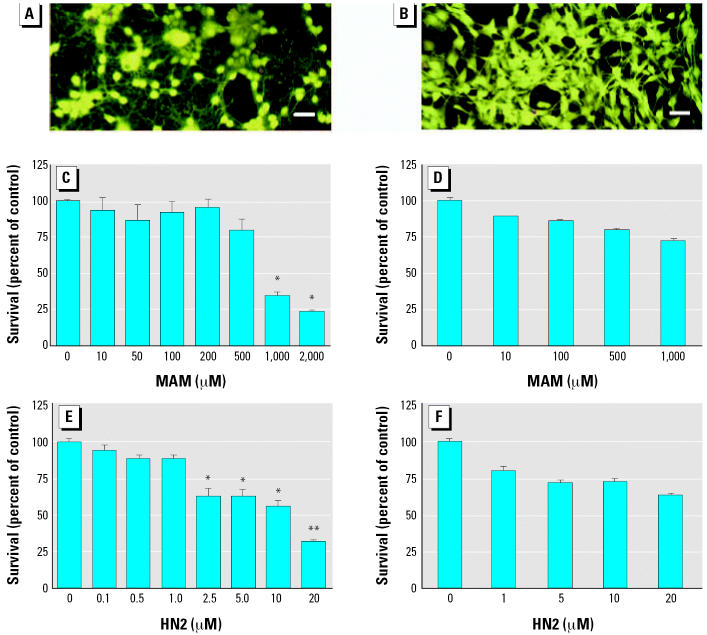
Comparative sensitivity of neurons and astrocytes to MAM or HN2. Representative epifluorescence micrographs of cultures of cerebellar neurons (A) and astrocytes (B). Bars = 50 μm (A) and 100 μm (B). Cultures of murine cerebellar granule cells (C,E) and astrocytes (D,F) were treated with various concentrations of MAM (10–1,000 μM) or HN2 (0.1–20 μM) for 24 hr, incubated with calcein acetoxymethyl ester and the cells examined for fluorescence. Values represent the mean percent survival of controls ± SE (n = 6/treatment, 2–3 experiments).Significantly different from control cells (*p < 0.01) or genotoxicant-treated astrocytes (**p < 0.01 by ANOVA).